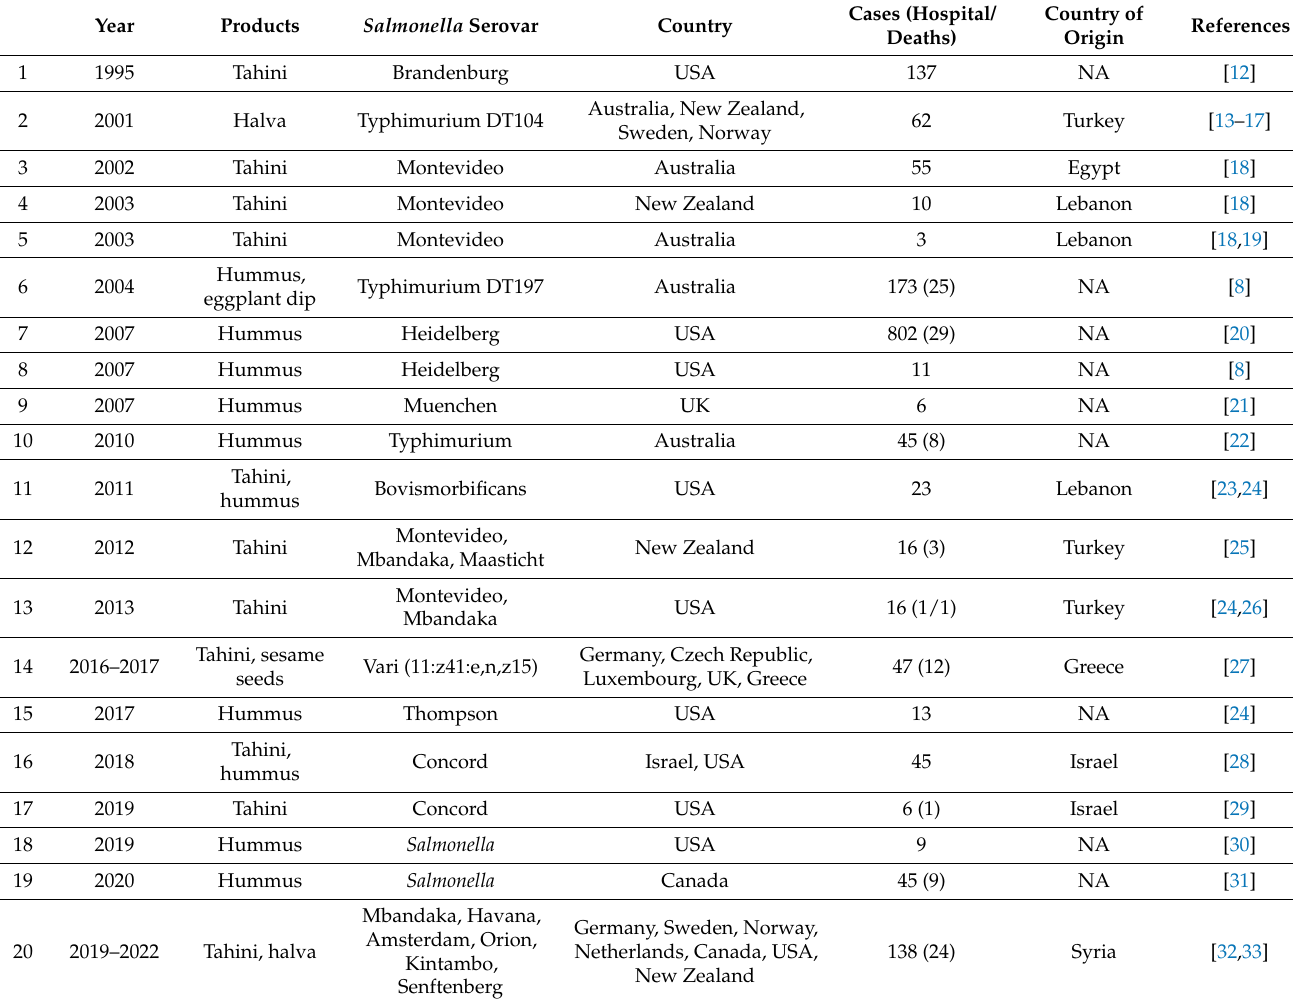
Table 1. Known salmonellosis outbreaks linked to tahini and tahini-based products,